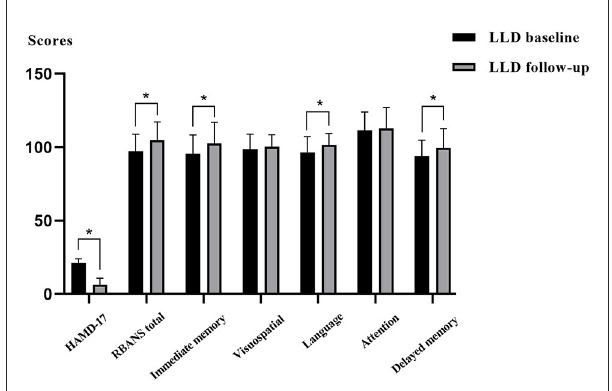
FIGURE2 Comparisons of depressive symptoms and cognitive function between the LLD baseline group and LLD follow-up